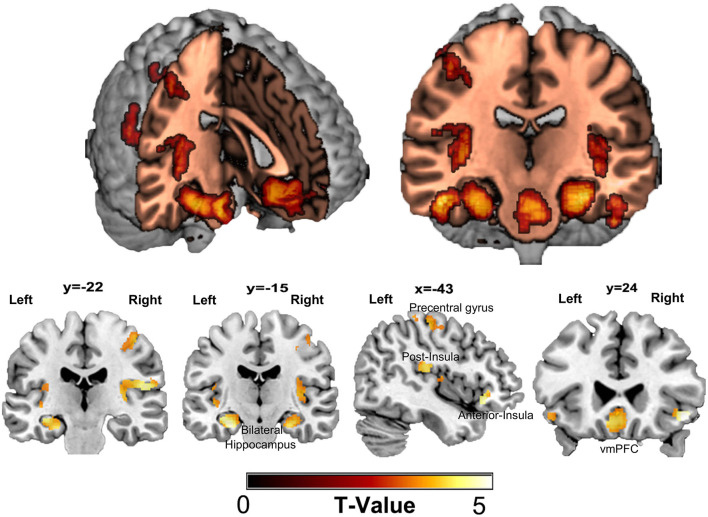
Regional gray matter volume correlated with scores of somatic symptoms. A negative correlation was found between gray matter volume (GMV) and the score of somatic symptom in some clusters that mainly included areas in the ventral medial prefrontal cortex (vmPFC), bilateral hippocampus, bilateral amygdala, bilateral somatosensory cortex, and extend into the posterior insula, inferior frontal cortex adjoin to the anterior insula. There was no significant positive correlation between GMV and the scores of psychological responses based on FWE-corrected.